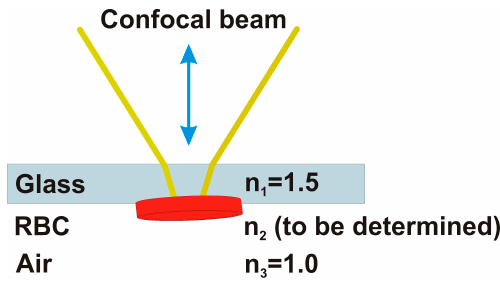
Figure 3. The incoming beam is propagating in air before entering the 1 mm thick glass slide. The focus is searched at the second glass-air interface where there are some of red blood cells (RBC). Radiation is partially reflected back forming the reflected image. All the wavelengths are focused on the specimen (white light), while the spectroscopic analysis is made by a couple of spectrometers after the focus on the output pinhole.